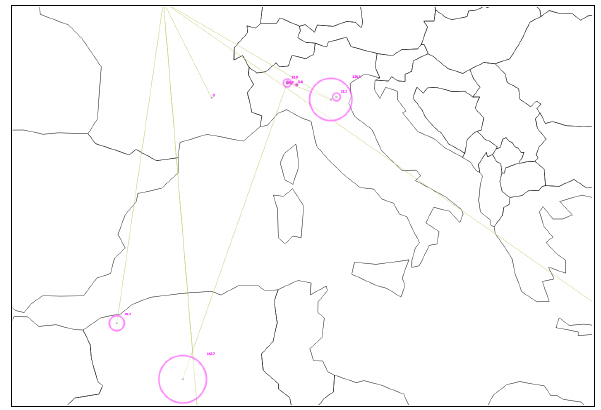
Figure 8. Enlarged portion of figure 7